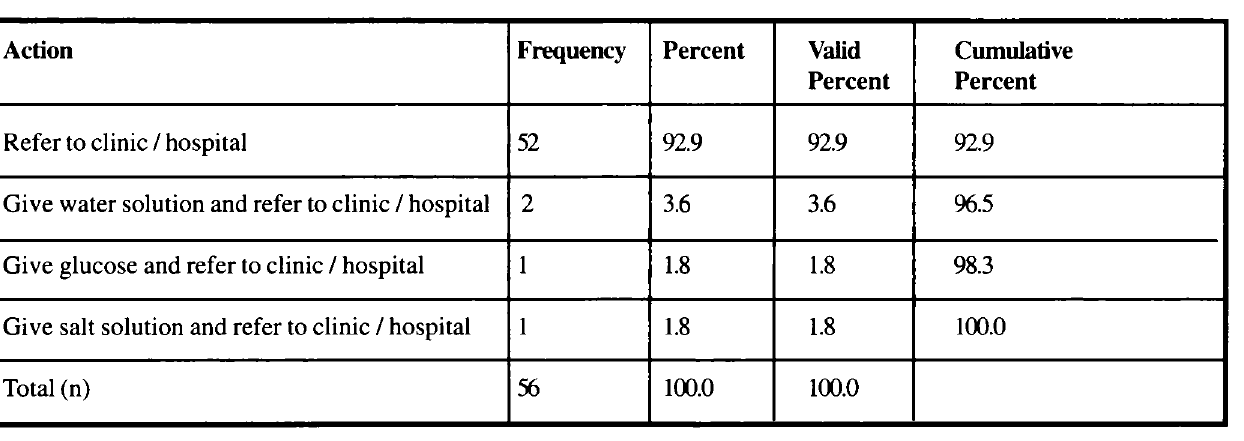
Table 4: Action taken by TBA if they encounter a risk sign